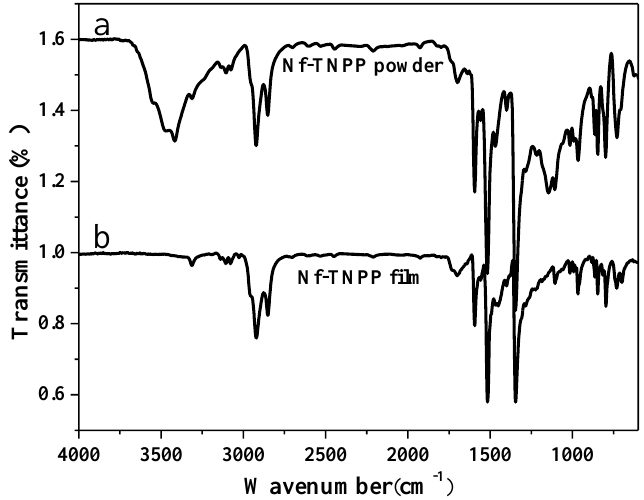
Figure 4. FT-IR spectra of TNPP: (a) powder and (b) thin film